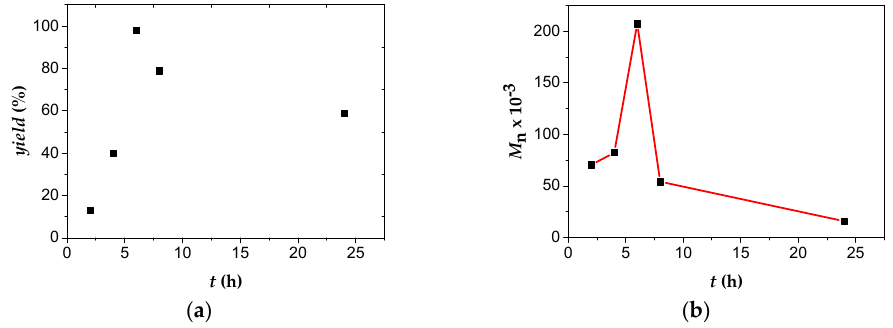
Figure 4. Polymerization of PA (653 μ L, 608 mg, 6.0 mmol) with 1 (30.0 mg, 0.017 mmol), AgBF 4 (9.9 mg, 0.051 mmol) and 10 mL THF (25 °C); ( a ) % yield vs. time plot of PPA; ( b ) M n × 10 − 3 vs. time plot.